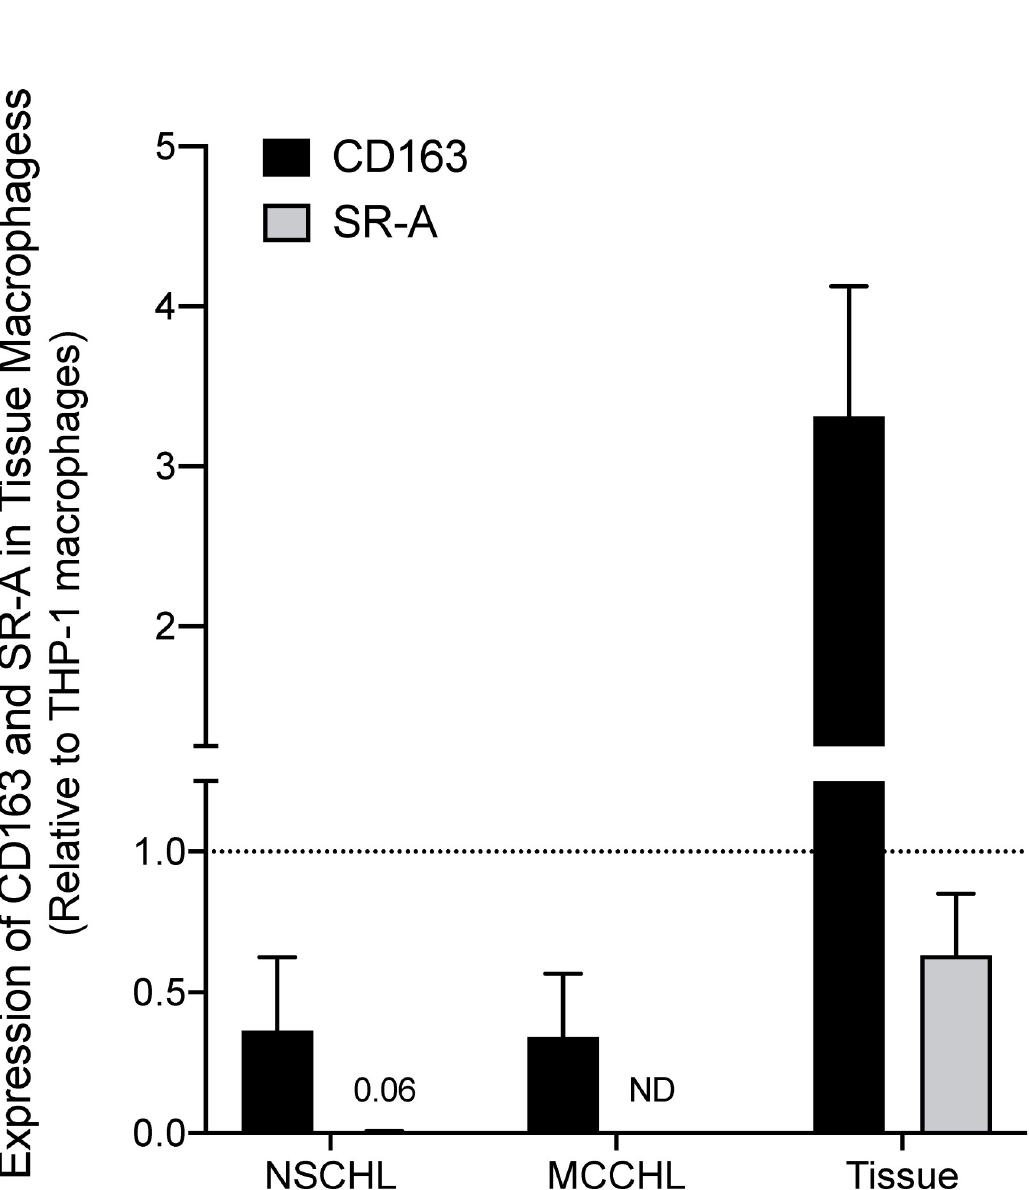
Fig 7. CD163, CD14 and SR-A expression in nodal CHL, lung and liver assessed by qRT-PCR. Total RNA was prepared from FFPE sections of nodal NSCHL (n = 2) and MCCHL (n = 2), from tissue (lung and liver), and differentiated THP-1 macrophages (positive control). After reverse transcription, qRT-PCR was used to quantify expression of CD68, CD163, and SR-A. Relative expression of CD163 and SR-A in macrophages was calculated by normalizing their Ct values to that of CD68 in the same sample ( Δ Ct), and then to their expression in THP-1 macrophages ( ΔΔ Ct). CD163 expression was readily detected in nodal CHL and lung/liver (tissue), and to a lesser extent in NSCHL and MCCHL. SR-A expression was readily detected in tissue, but was only detected at very low levels in NSCHL and not detected (ND) in MCCHL.